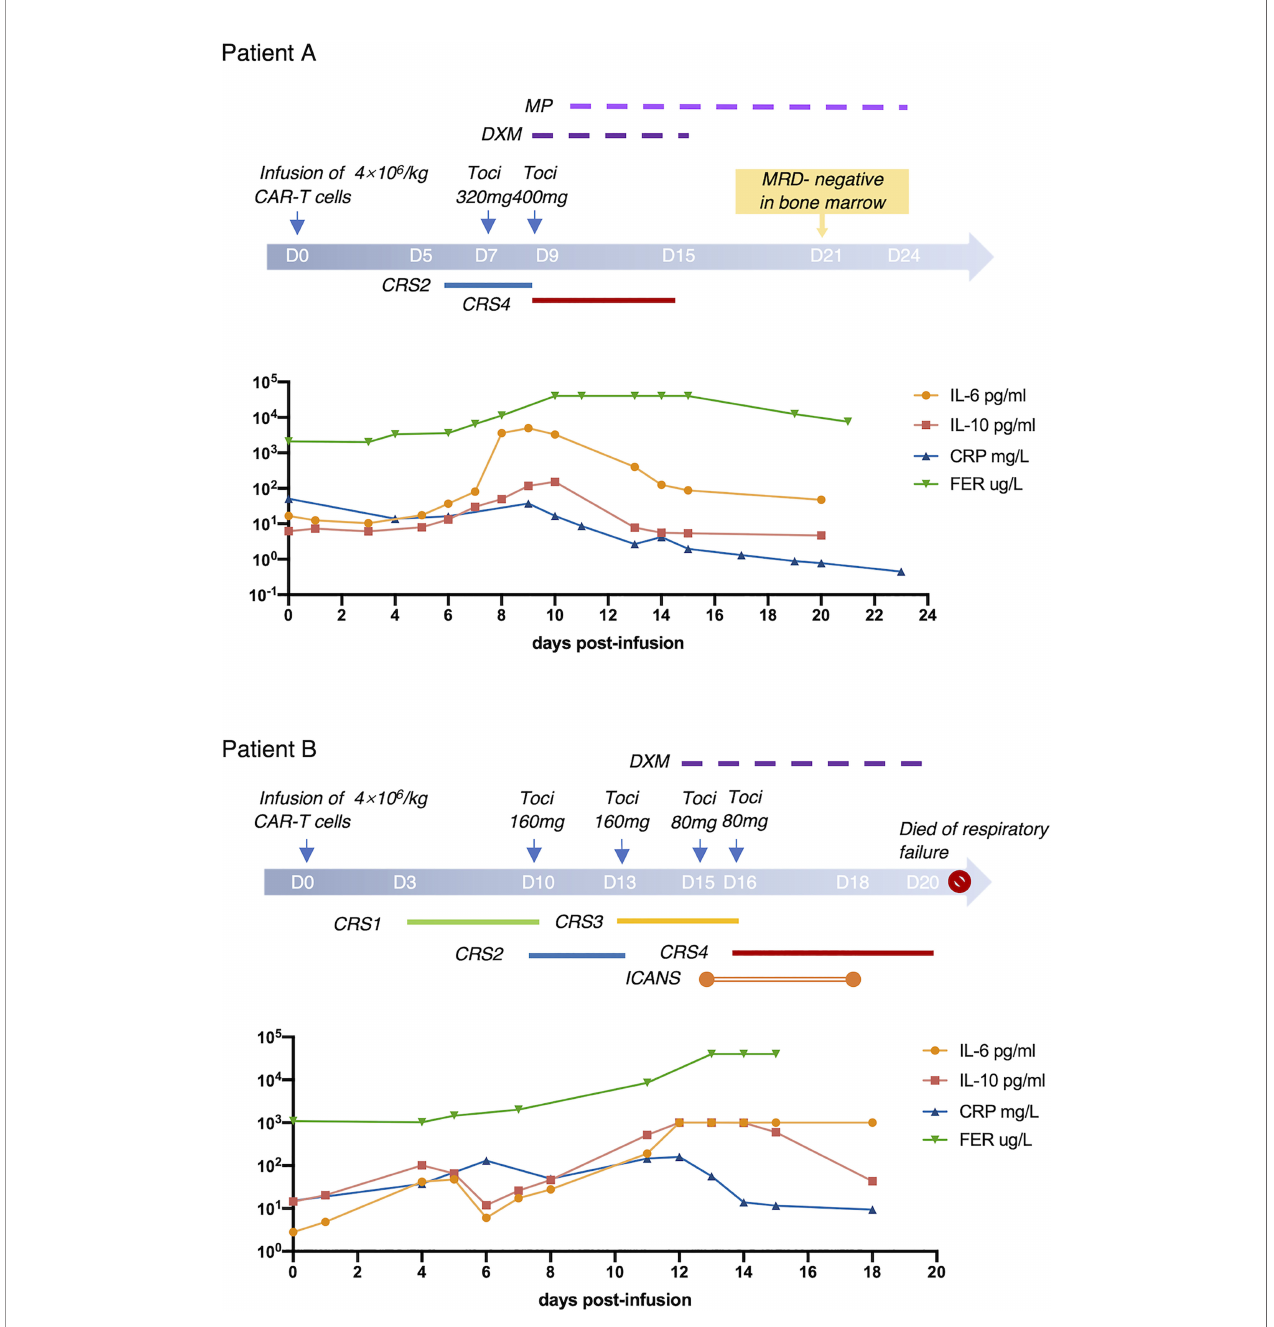
FIGURE 2 | Two Cases With Severe CRS. Progression and treatment of two typical patients with severe CRS. MP, methylprednisolone; DXM,